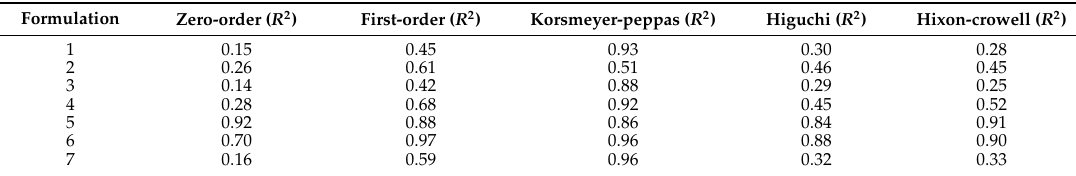
Table 2. The amount of vancomycin was plotted against time on the x -axis. The average of each formulation was then fitted to each of the common pharmacokinetic models to identify the best fit.